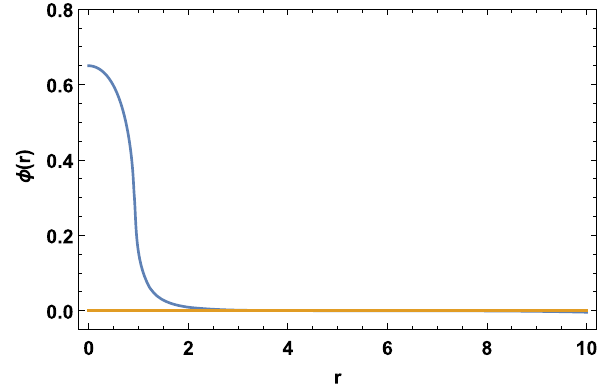
Fig. 5 ThefunctionCrit ( r ) = − Z ( r )/( 2 σ g 2 ) forthecaseoftheelastic body which determines the value of r b at which it vanishes